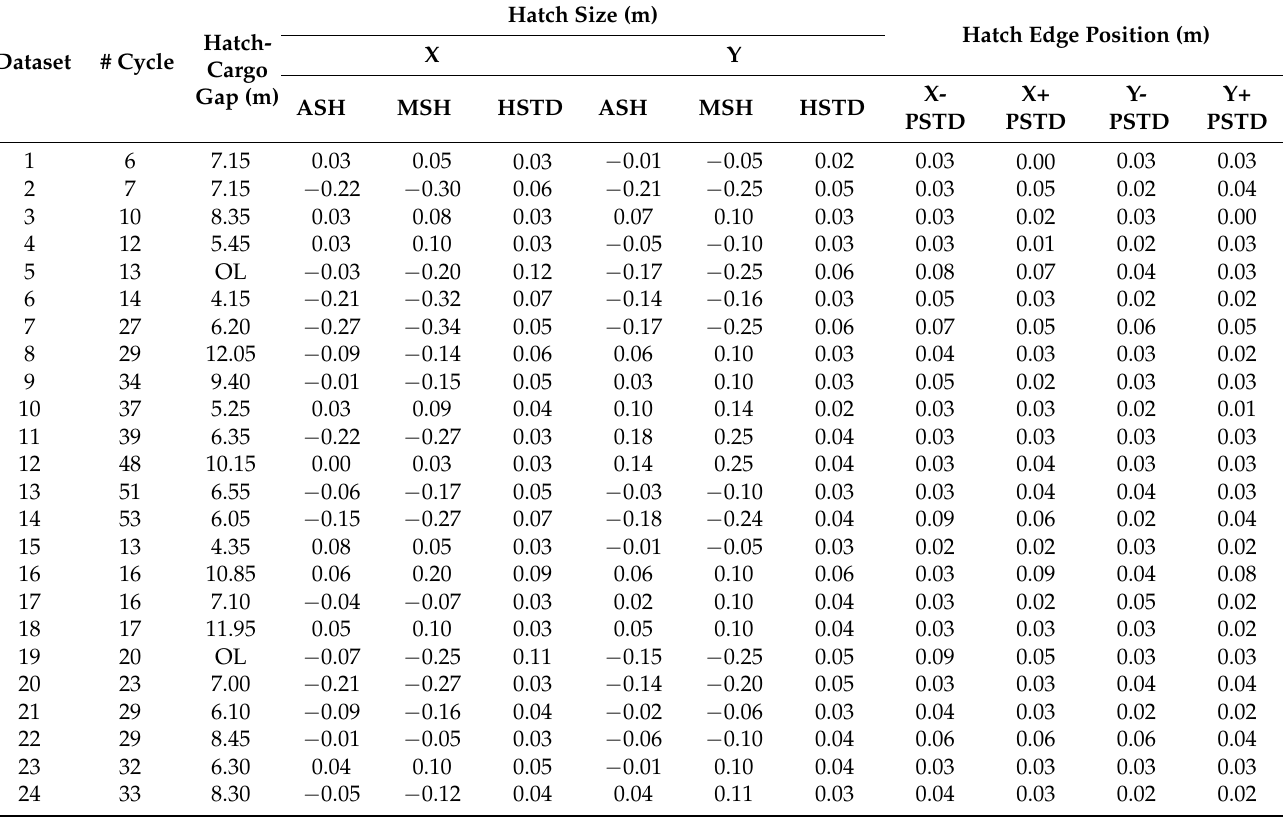
Table 1. Hatch extraction statistical results over 608 cycles from 24